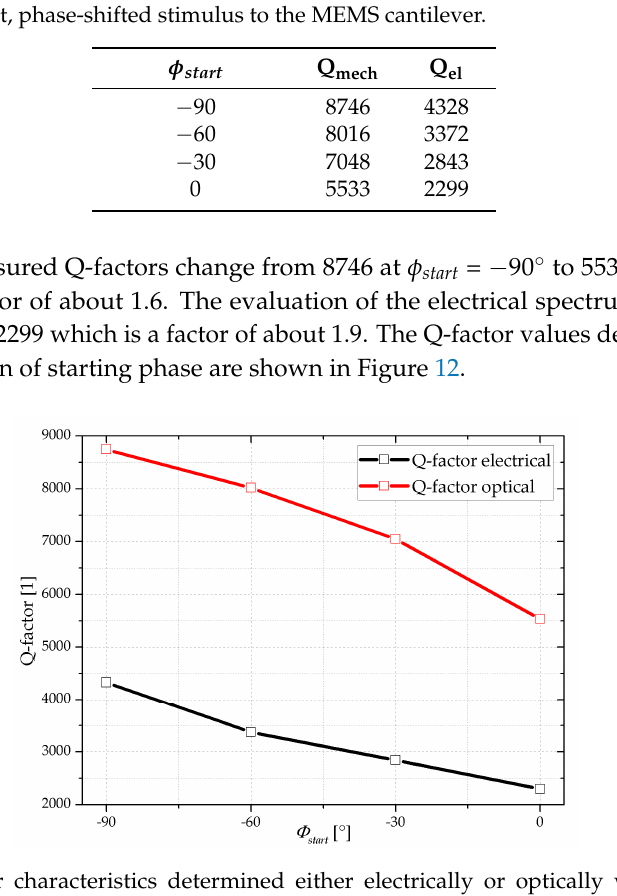
Figure 12. Q-factor characteristics determined either electrically or optically when applying a frequency-dependent, phase-shifted stimulus to the MEMS cantilever. The inserted lines serve as guide to the eyes.